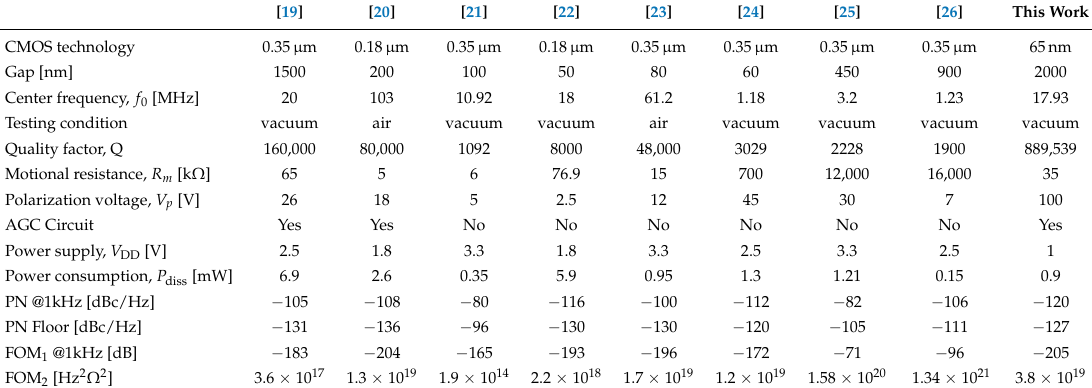
Table 2. Performance comparison of the proposed oscillator with the